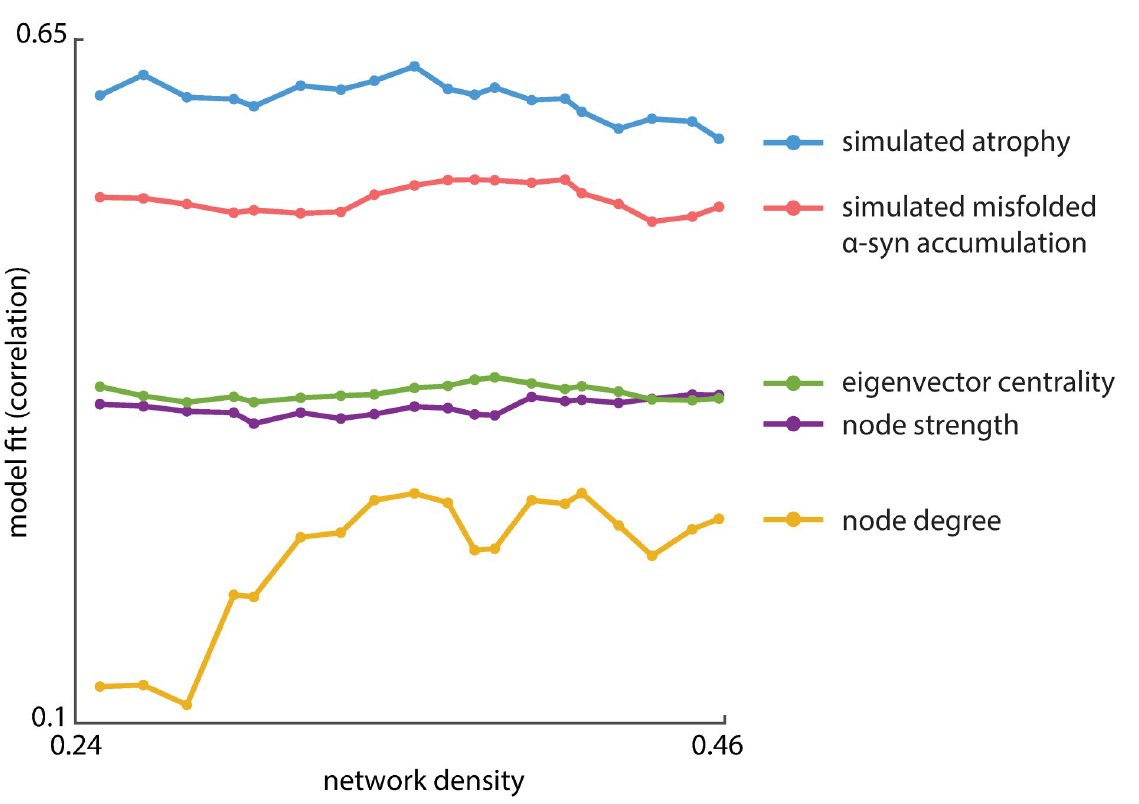
Fig 3. The full dynamic model outperforms static network measures across multiple network densities. The full spread model has more predictive power than static topological metrics, including node degree (yellow), node strength (purple), and eigenvector centrality (green). Moreover, simulated atrophy (blue) from the full agent-based model yielded higher correlation with empirical atrophy than the modeled density of misfolded α -synuclein (red, peak correlation along t at each density), suggesting that loss of neuronal tissue resulting from misfolded α -synuclein accumulation plus deafferentation is a better measure of atrophy in PD than the mere accumulation of misfolded α -synuclein. Model fit was assessed using Spearman’s correlation coefficient. The overall pattern of results was consistent across multiple network densities. Using Pearson’s correlation coefficient yielded similar results (S5 Fig). For the same analysis using two finer-grained anatomical parcellations, see S6 Fig. The underlying data can be found at https://github.com/yingqiuz/SIR_simulator/blob/master/results/Fig3.mat. α -syn, α -synuclein; PD, Parkinson